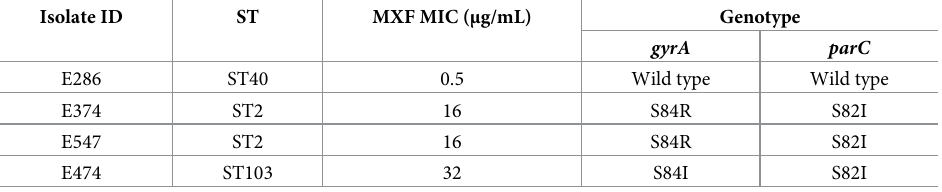
described before [23, 41], and likely explain the fluoroquinolone resistance observed in these isolates. Finally, ceftazidime resistance was quite variable between isolates, with MICs ranging from 78.125–625 μ g/mL (Table 1). In general, isolates belonging to the same ST had similar cef- tazidime susceptibilities, with MICs falling within two-fold of one another. The one exception was the three ST122 isolates, which were all isolated from the same patient [13]. The first two isolates from the patient (E616 and E623) had ceftazidime MICs of 78.125 μ g/mL, while the final isolate (E633) had an eight-fold higher MIC (MIC = 625 μ g/mL). Emergence of reduced ceftazidime susceptibility in a hypermutator strain isolated from recurrent endophthalmitis Whole-genome sequencing revealed that three E . faecalis isolates collected from a single patient with recurrent endophthalmitis were closely related to one another [13] (Fig 1). Using the first isolate from the patient (E616) as a reference, we looked for variants that arose in E623 (isolated 16 weeks after E616) and E633 (isolated 20 weeks after E616 and then grown in thio- glycolate broth for three additional months before sequencing) [13]. We identified four Table 2. Amino acid substitutions in gyrA and parC identified in fluoroquinolone-resistant E . faecalis endophthalmitis isolates.